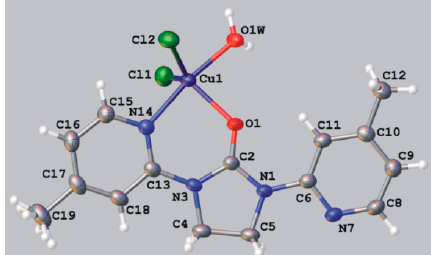
Figure 4. ORTEP representation of molecular structure of 7